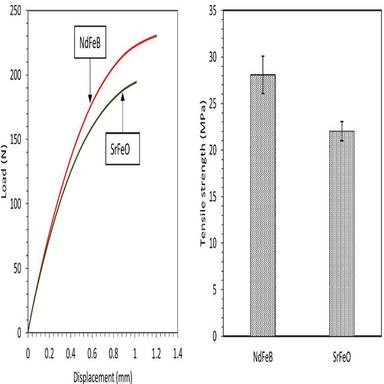
(Left) Load (vs) Displacement curves of magnetic composites (Right) Tensile strength of magnetic composites.